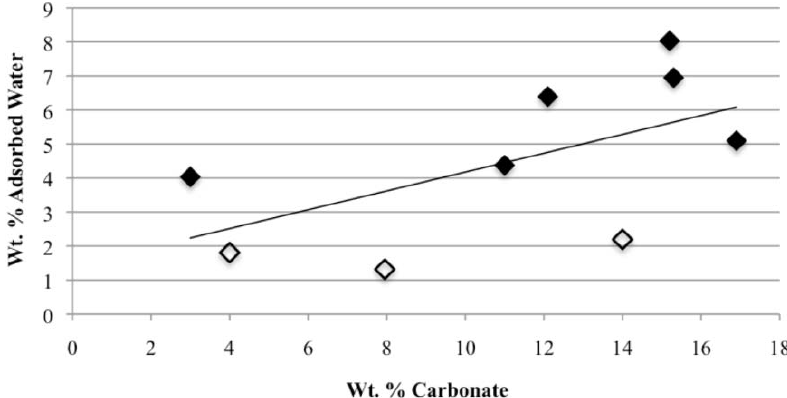
Figure 3. Weight percent adsorbed water as a function of weight percent carbonate in carbonated hydroxylapatite samples synthesized with one-hour digestion periods. Hollow diamonds indicate a synthesis and digestion at 80 °C as opposed to the 60 °C synthesis and digestion of the other samples. The regression line is for all samples prepared with a one- hour digestion period.